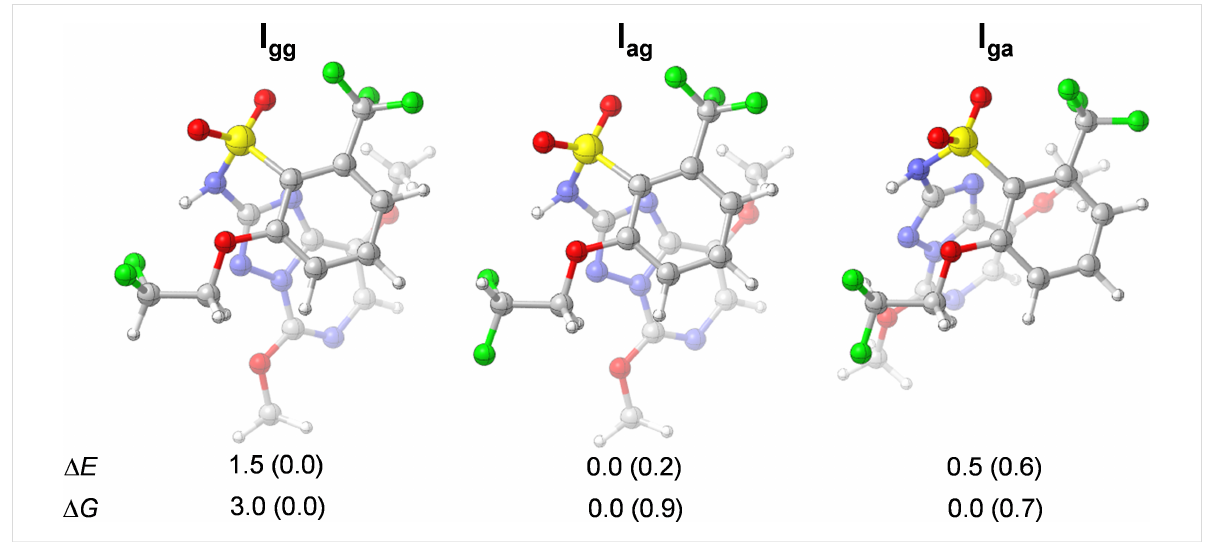
tional energy Δ E increases, i.e., becomes less stabilizing, in the order I ag < I ga < I gg . The difference in energy between I ag and I ga is somehow small (0.5 kcal mol − 1 ), and these conformers are equally stable according to the relative Gibbs free energy Δ G (Boltzmann populations of 50% and 49%, respectively).